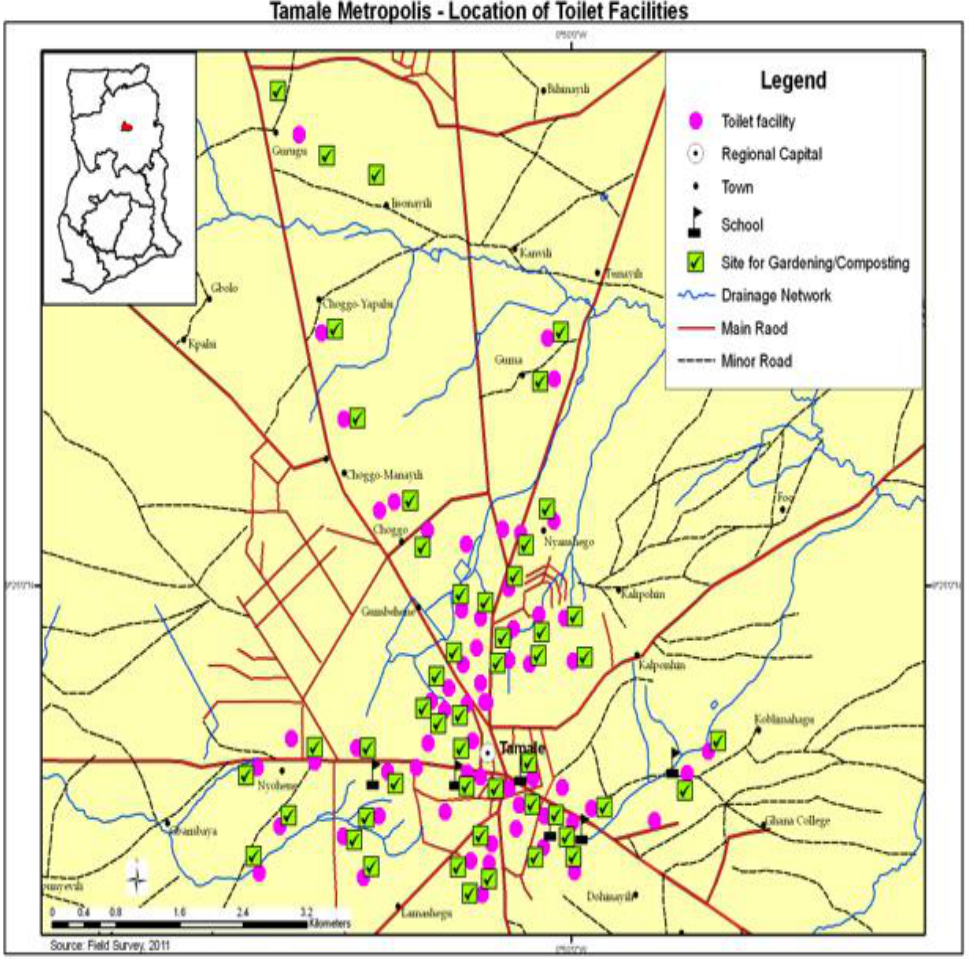
Figure 1. Map of Toilet Facilities in Tamale